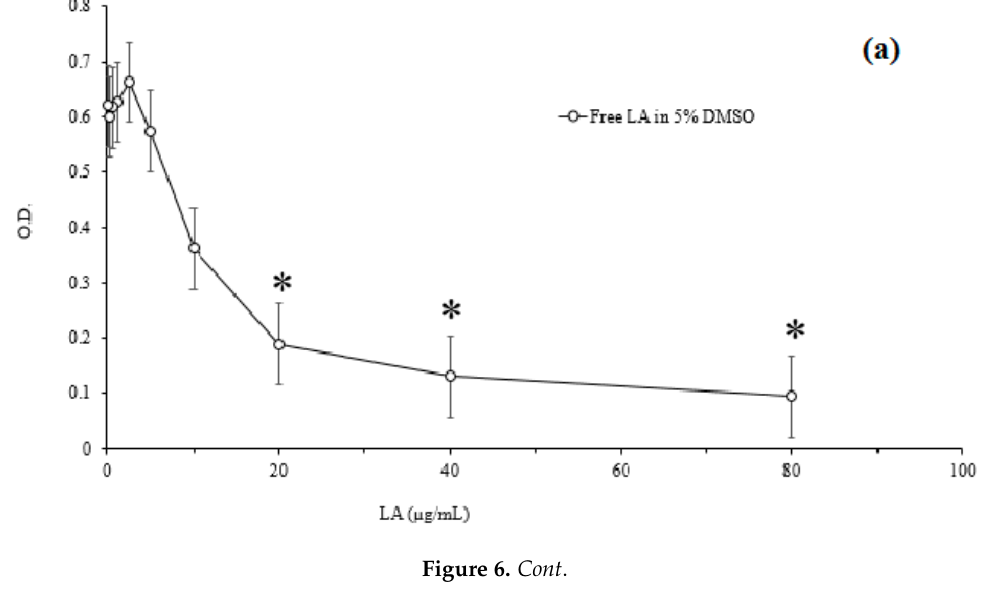
Figure 6. Cont Figure 6. Cont.